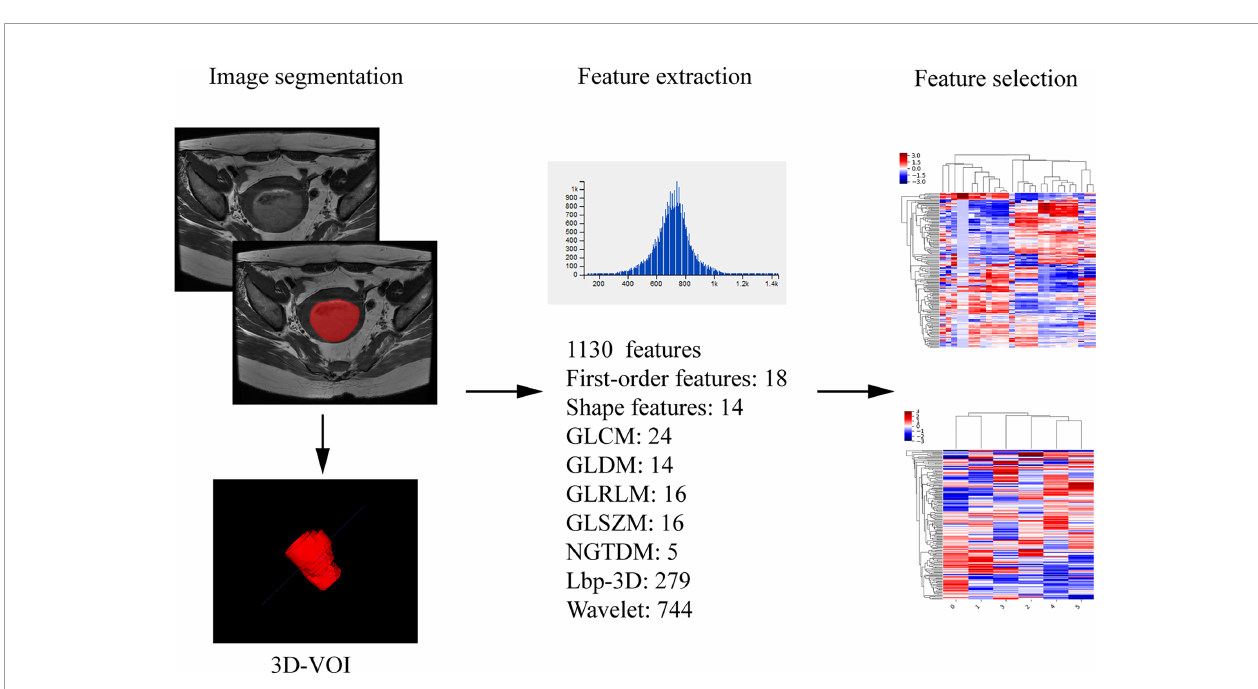
FIGURE 3 | Radiomics work fl ow.